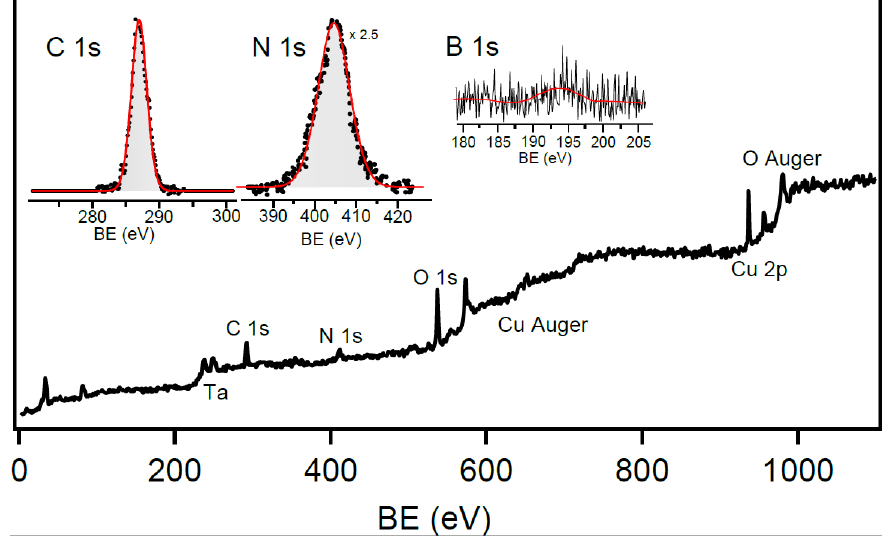
Figure Figure 6. XPS spectra of the prepared sample after thermolysis, in ultra-high-vacuum (UHV). Complete spectral overview and detail of the C 1s, N 1s and B 1s core levels (insets).